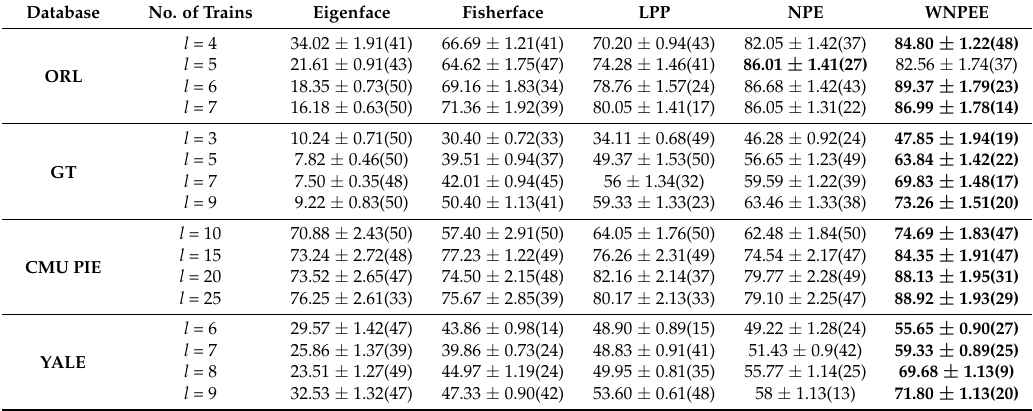
Figure 1. Sample face images of the ORL face database. Table 1. The average recognition rates of each method on four face databases with the corresponding STDs and dimension of best